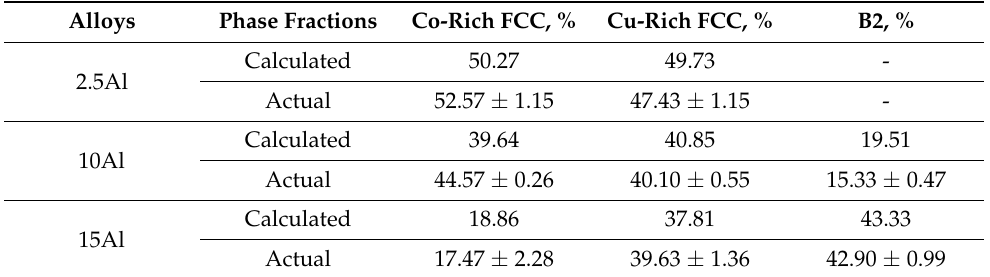
Table 2. The calculated fractions based on Thermo-Calc software and actual phase fraction of Co-rich FCC, Cu-rich FCC, and B2 in the present